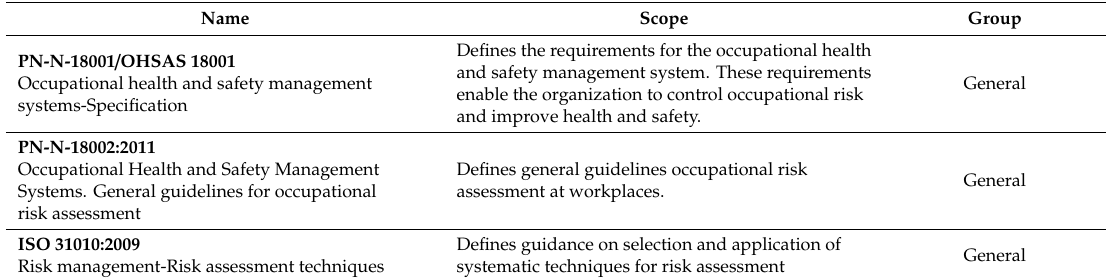
Table A1. Summary of the main standards regarding risk in mining